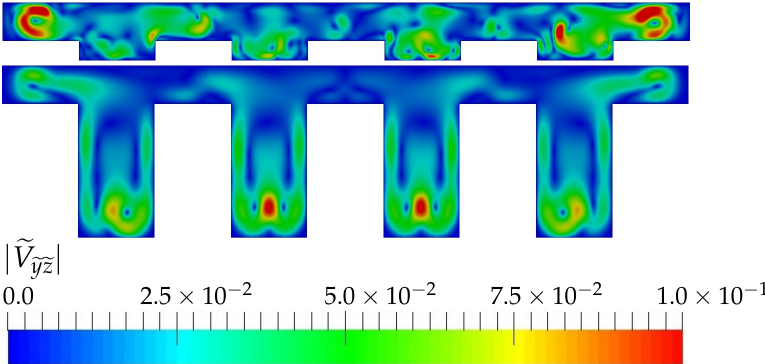
Figure 7. Transverse velocity at plane S 1 for Re = 700 and TR = 0.5 and different AR